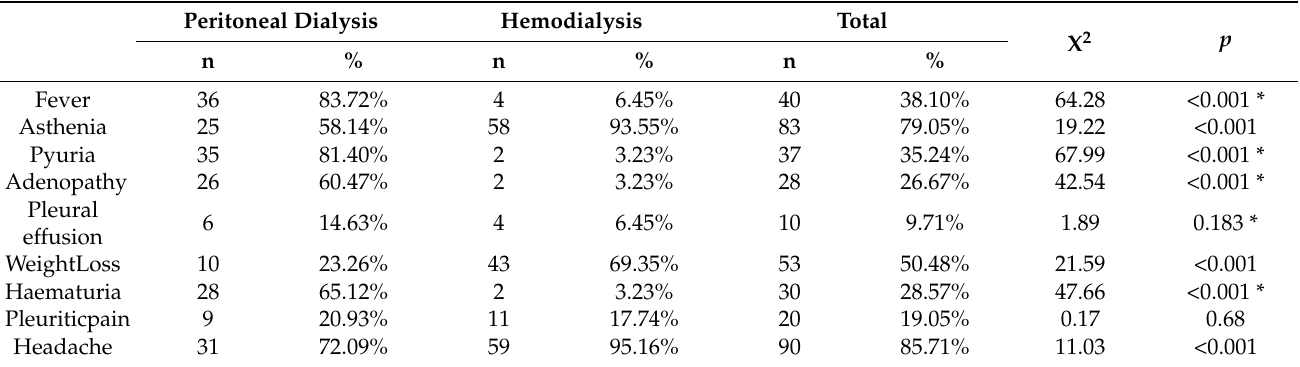
Table 2. Symptomatology by type of renal replacement